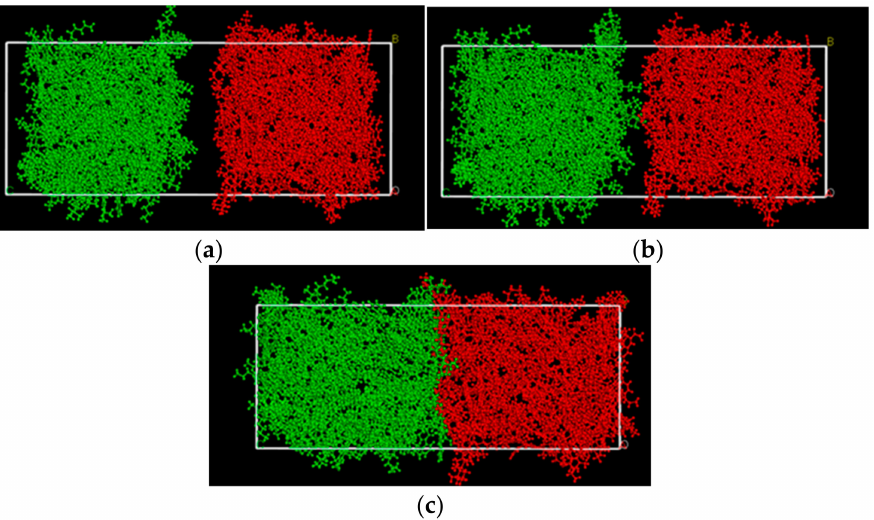
Figure 4. Diffusion between virgin and aged asphalt at 383.15 K: ( a ) t = 0; ( b ) t = 5 ps; ( c ) t = 100